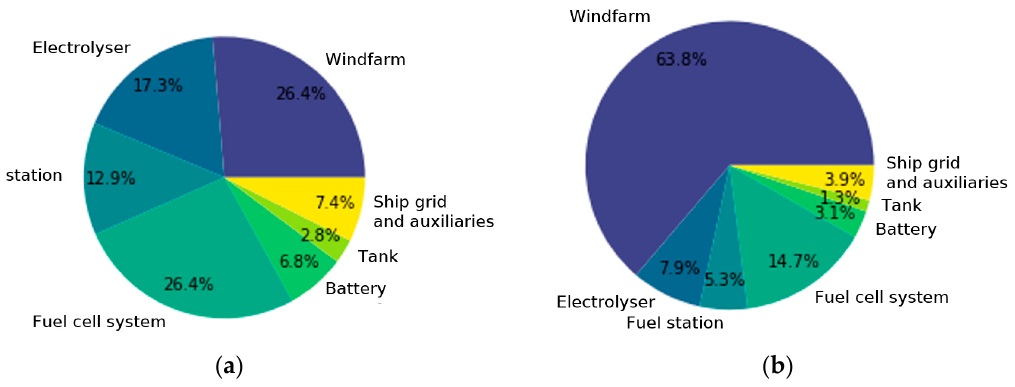
Figure 6. Estimated fuel system cost proportions: ( a ) Earl Thorfinn at a total CAPEX of 15.92 million EUR, ( b ) Frisia III at a total CAPEX of 26.25 million EUR (Source: By author).